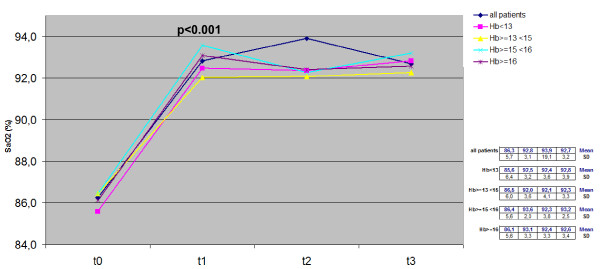
Time course of SaO2values in the whole cohort and in each subgroup:ttest between t0and t1. Hb, hemoglobin; SaO2, oxyhemoglobin saturation.